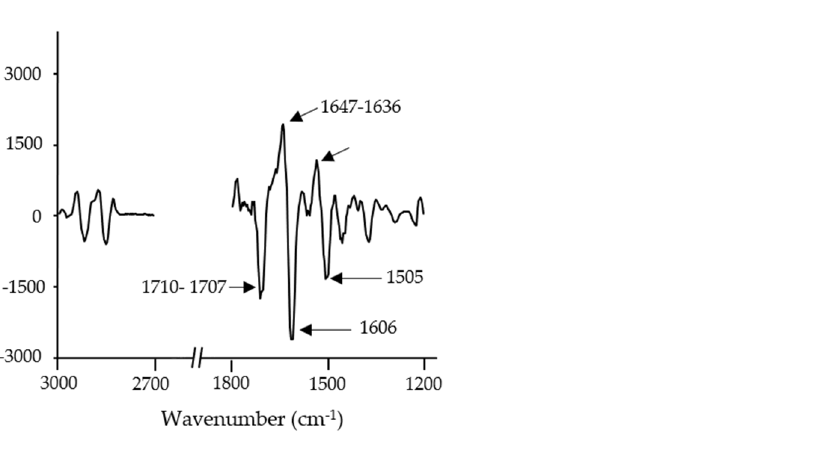
Figure 13. PLSR regression vector plot of FTIR spectroscopy spectra (3000–2700 cm − 1 and 1800–1200 cm − 1 ) from an A. diaperinus snack model.